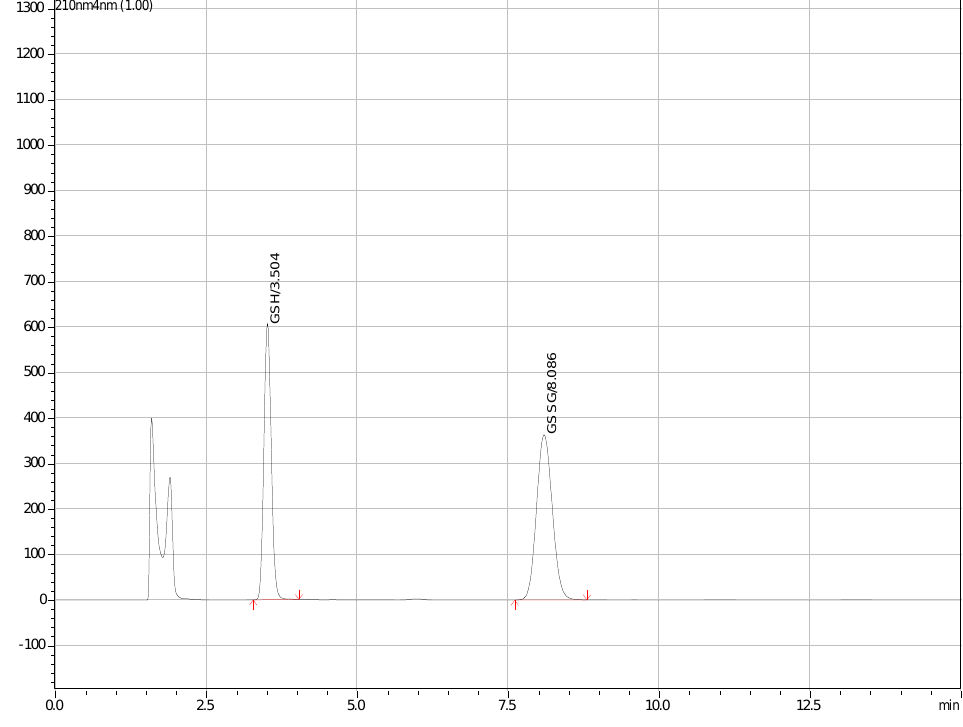
Figure 2. Representative HPLC chromatogram from the analysis of a mixture of GSH and GSSG (500 mg L −1 each).